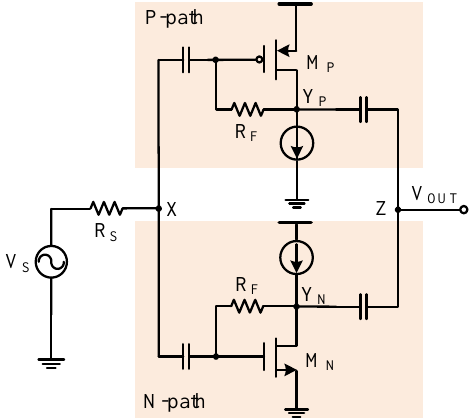
Figure 7. Complementary resistive shunt-feedback amplifier.